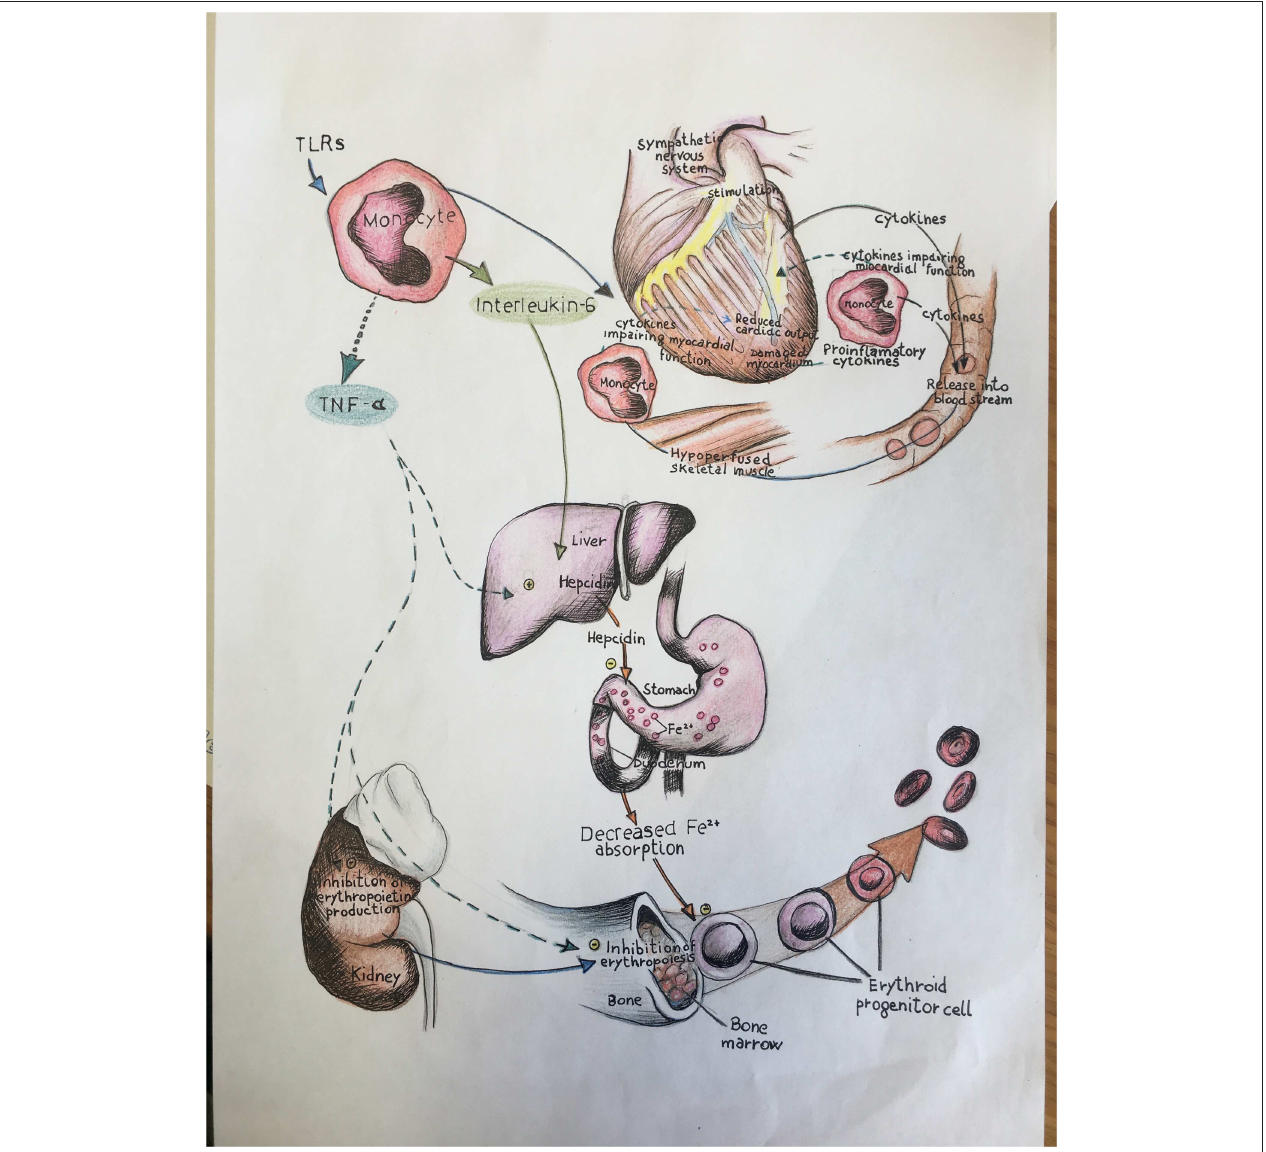
FIGURE 1 | In this illustration we schematically report the role of immune-mediated inflammation in iron status balance and the consequent effects on cardiac function in heart failure. TLRs, toll-like receptors; TNF- α , tumor necrosis factor alpha; IL,